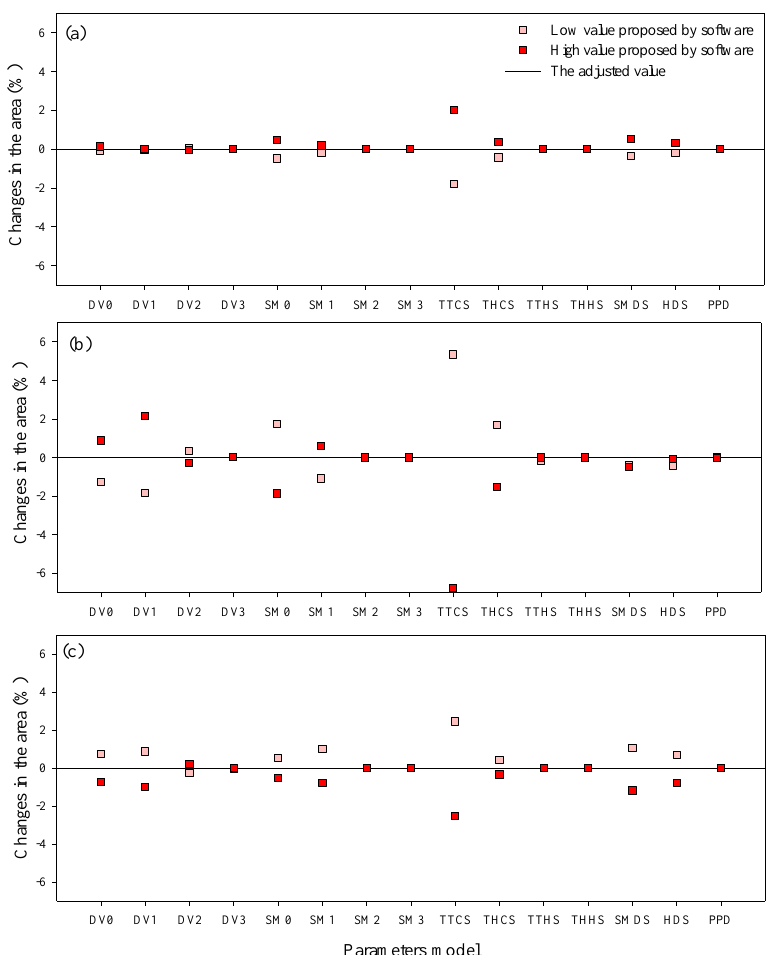
Figure 4. Changes in unsuitable areas (EI = 0) ( a ), low-suitability areas (0 < EI < 30) ( b ), and high- suitability areas (30 < EI < 100) ( c ), in %, for U. panicoides , in sensitivity analysis using CLIMEX, based on parameters of greater sensitivity for the Ecoclimatic Index (EI). The values for the parameters used are shown in Table 1.